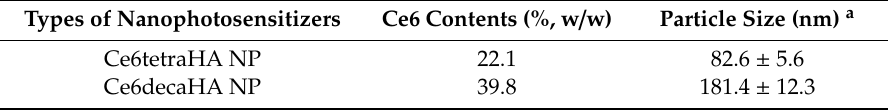
Table 1. Particle size of